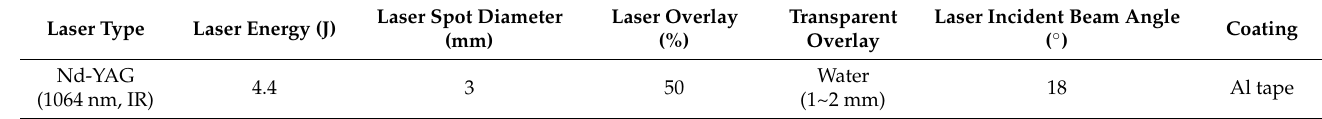
Table 4. Conditions of laser peening